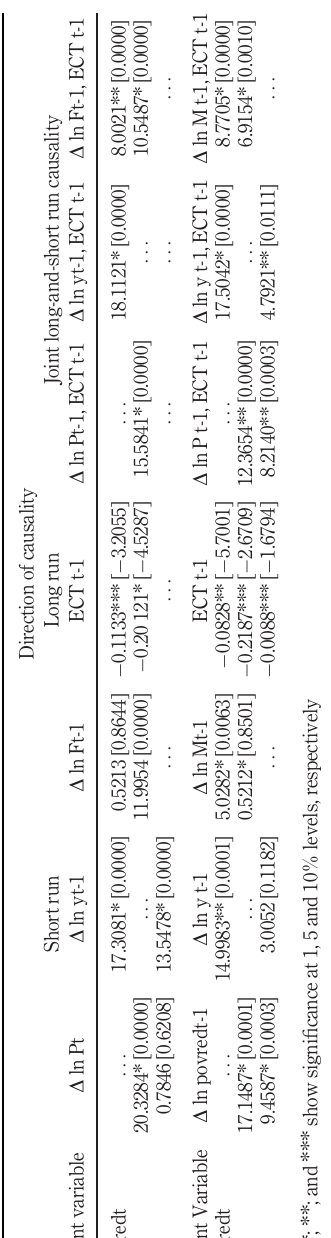
Table IV. The VECM Granger causality